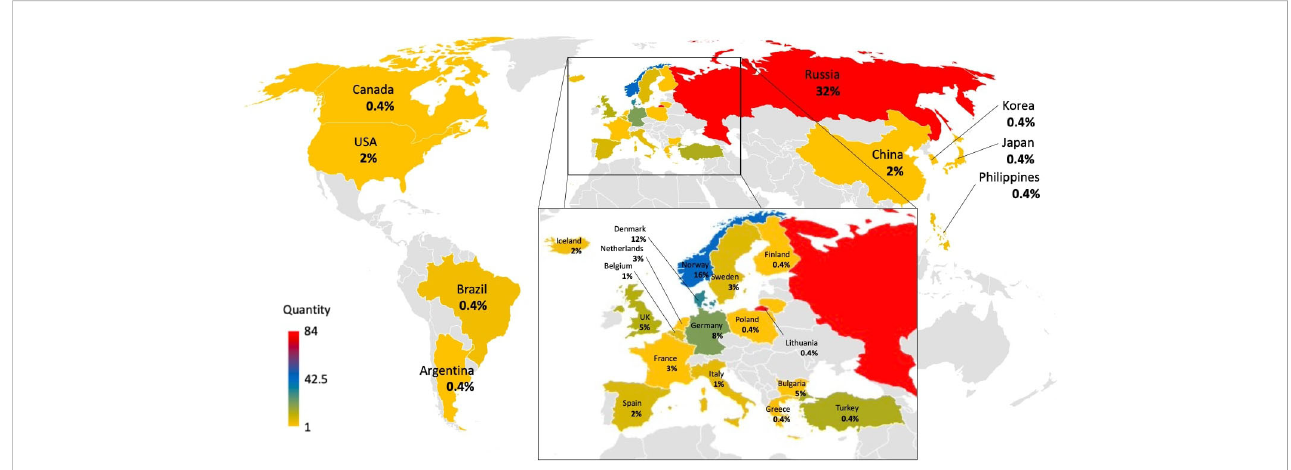
FIGURE 6 Origin of items depicted in a map. Countries and proportions marked, color of countries show number of assigned items.